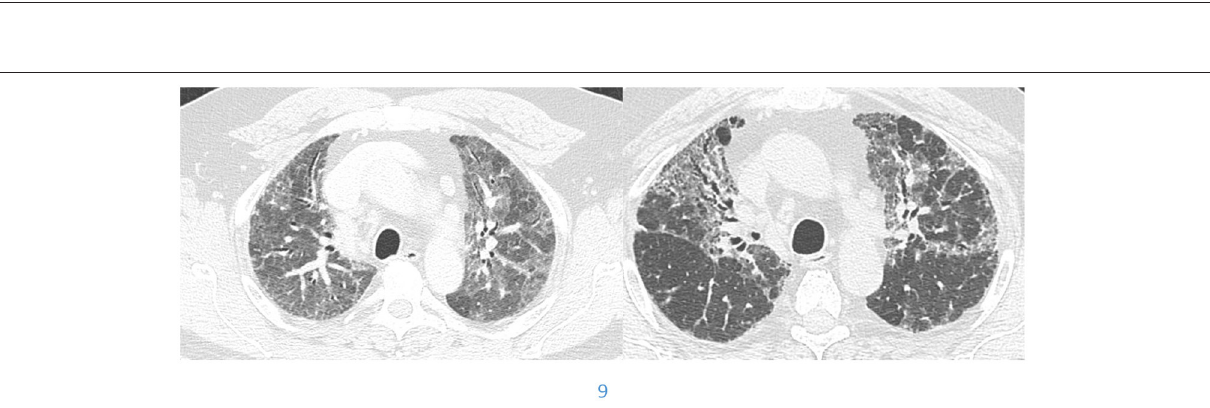
FIGURE 5 | Evolution of hypersensitivity pneumonitis from non-fibrotic to fibrotic phenotype over a 39 month period.